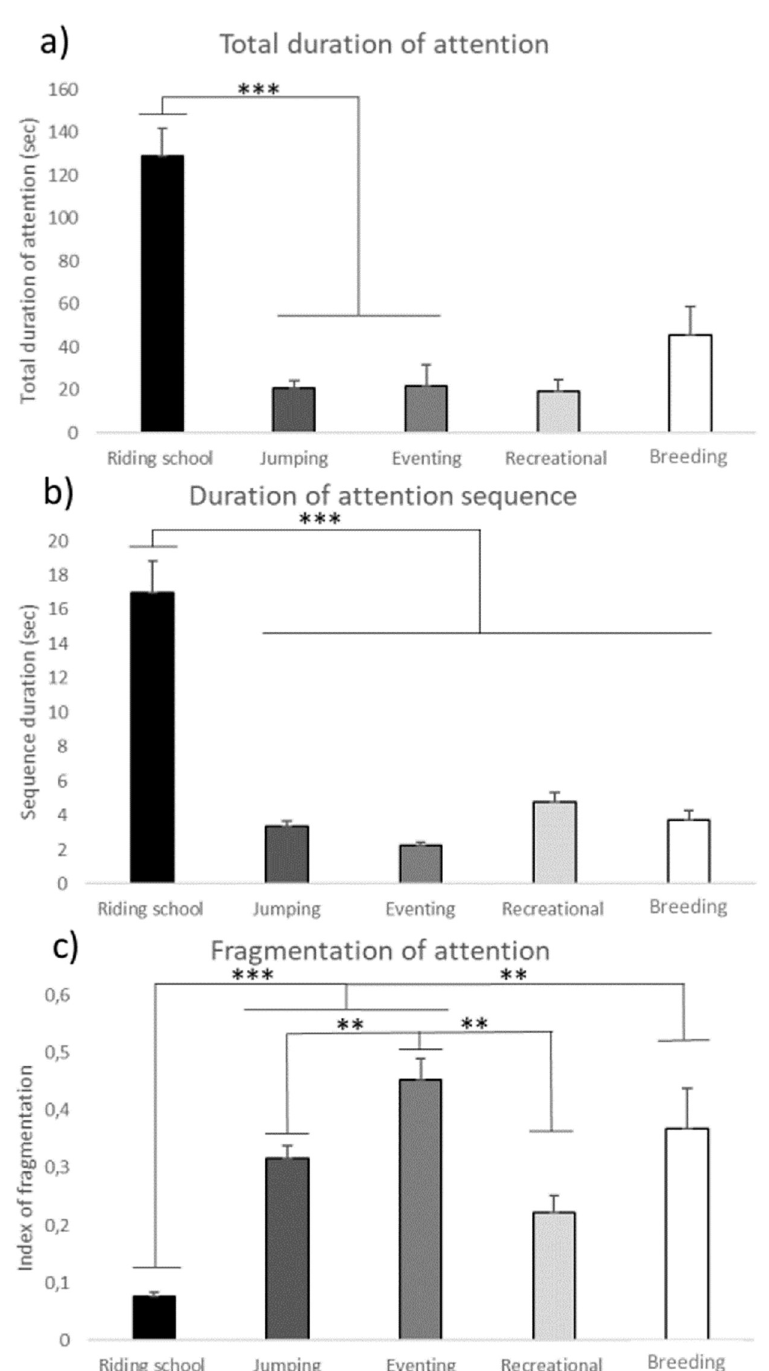
Fig 3. Mean ± SEM of attention characteristics according to the type of work. a) total duration of overall attention (in seconds); b) average duration of overall attention sequences (in seconds); c) fragmentation of overall attention (ratio number of attention sequences / total duration of attention); Differences according to the type of work (site 1, riding school horses N = 27; site 2, sport horses N = 17 with jumping horses N = 10 and eventing horses N = 7; site 3, recreational horses N = 6; site 4, breeding horses, N = 12). LM with post-hoc t-test with Tukey correction, �� P < 0.01; ��� P < 0.001.